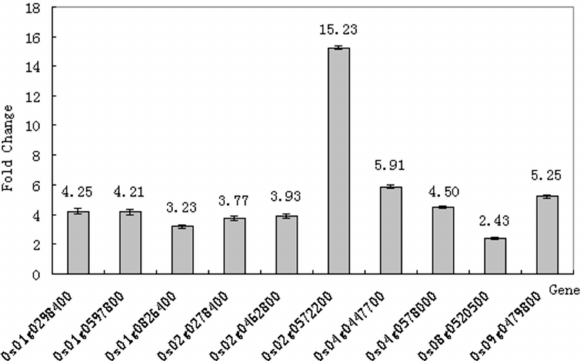
Figure 6. Transcriptional changes were analyzed using RT-qPCR. The expression gene annotation can be found in Table 3, the primers used for the RT-qPCR are presented in Table S1, while the fold change values represent the average of three independent biological replicates for comparison with microarray data, the actin gene was used as an internal control. Values are means of three experiments each with three replications; PEG, Water deficit treatment induced by PEG for 10 h without COR pretreatment; COR + PEG, Pretreatment with 0.1 µ M COR for 12 h before PEG treatment. The sample was collected 10 h after treatment.